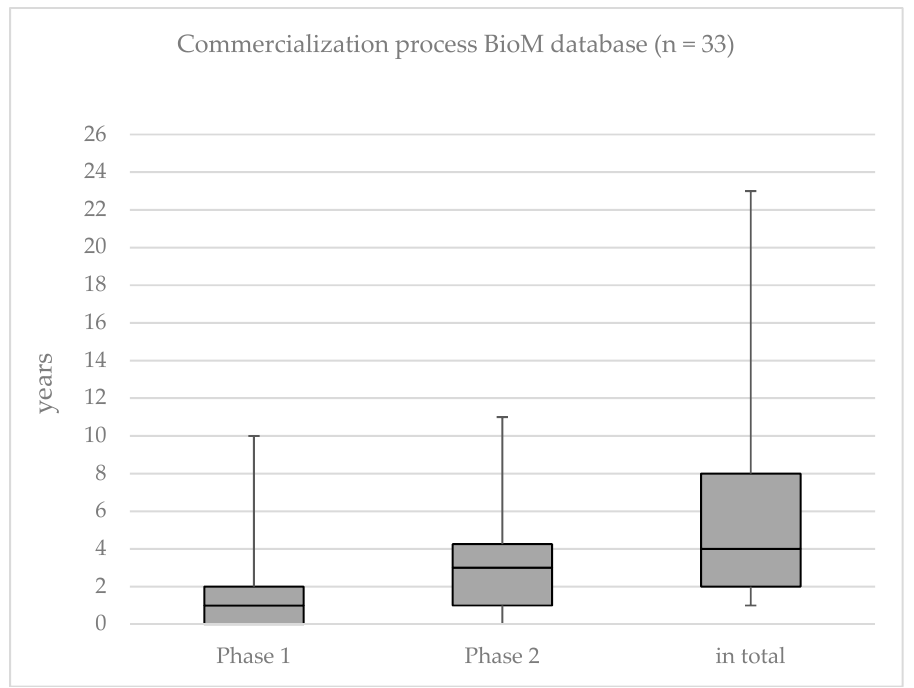
Figure 5. Duration of the commercialization of 33 BID products in years. Phase 1: concept to prototype; phase 2: prototype to market.